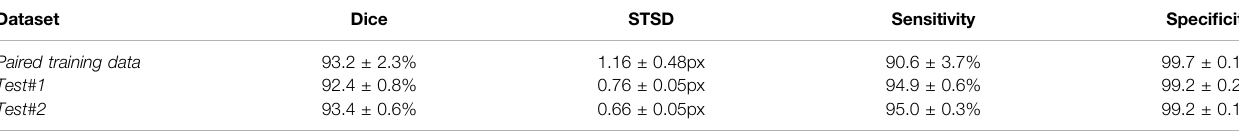
TABLE 3 | Technical evaluation forleft atrium reconstruction from point cloudsin the300 generated ( Paired training ),4clinical MRI( Test #1 ),and 2clinical CT( Test #2 ) data. Dataset Dice